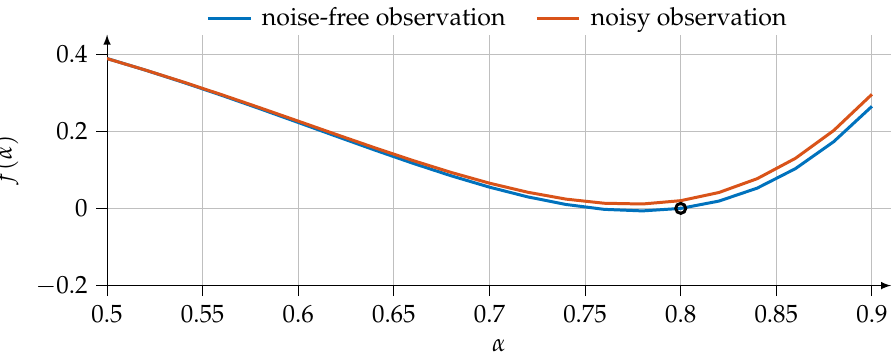
Figure 2. Visualizing the influence of the noise on the identification